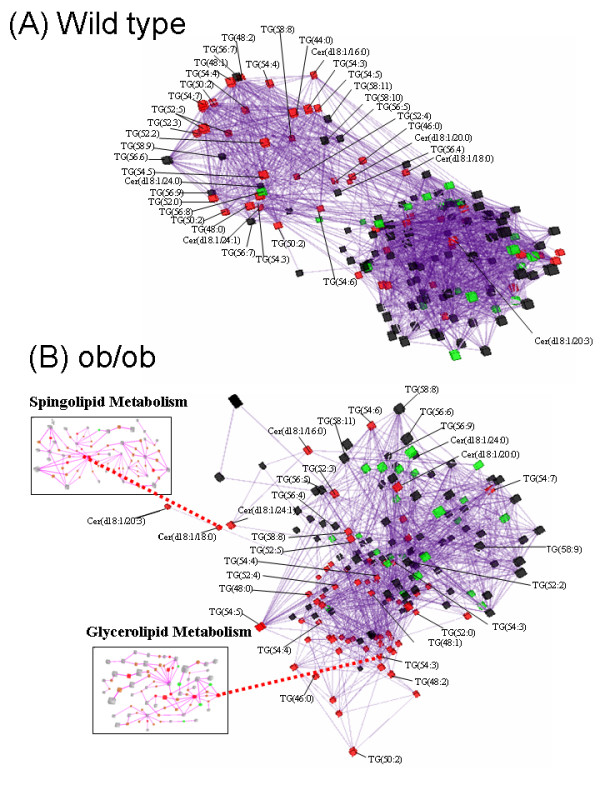
Correlation networks for ob/ob and WT mouse liver lipid profiles. Selected co-regulated cluster of lipid molecular species, including ceramides and acylglycerols. This network is based on Pearson correlation coefficient, r > 0.75 and statistic p-value < 0.001. Colored nodes in red (up regulation), green (down regulation) and black (no change) are based on 1.5-fold change cut off on mean value comparisons for ob/ob vs. WT mice. (A) Correlation network for WT mouse liver lipidomic data (B) Correlation network for ob/ob mouse liver lipidomic data.